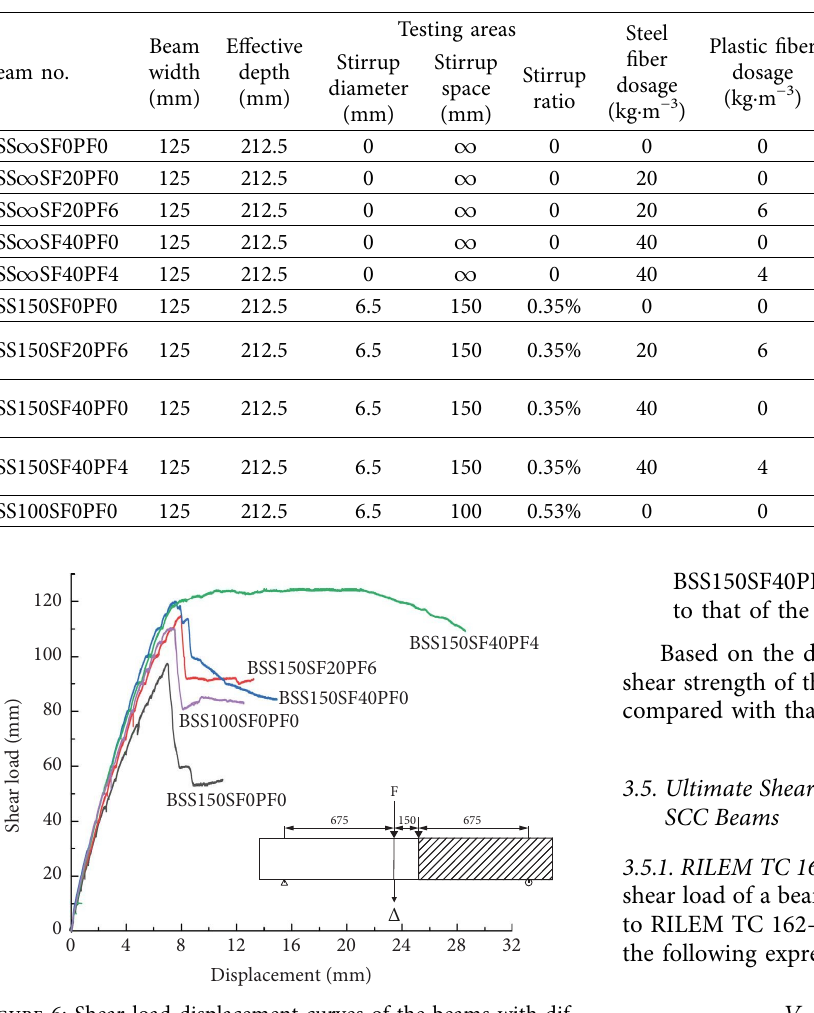
Figure 6: Shear load-displacement curves of the beams with dif- ferent fber types and